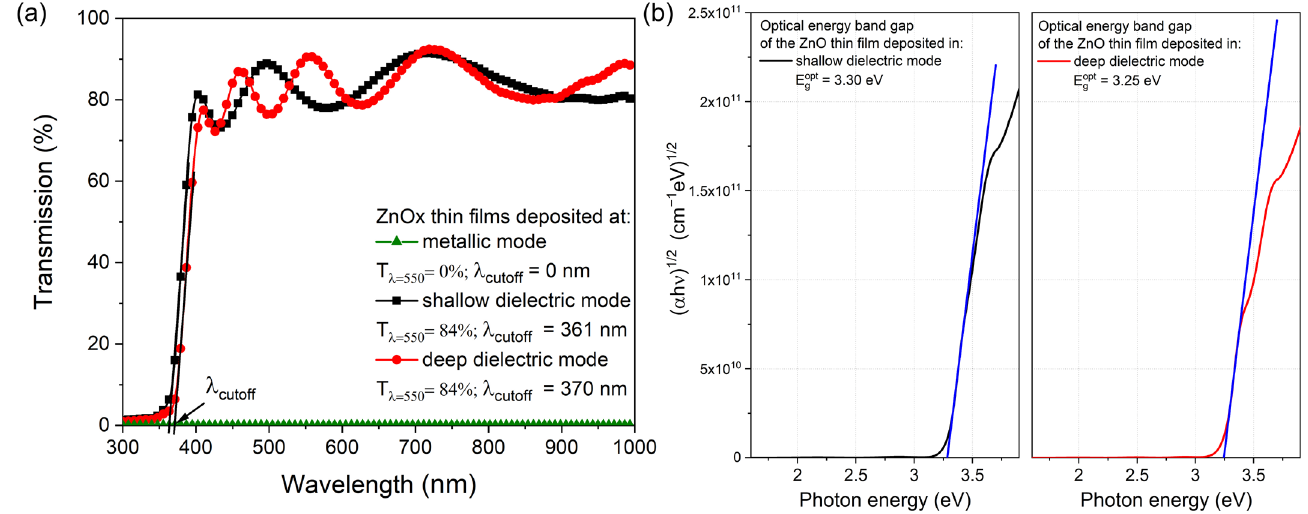
Figure 8. Transmission spectra ( a ) and Tauc plots ( b ) of transparent ZnOx thin films prepared in shallow dielectric and deep dielectric modes of magnetron sputtering.